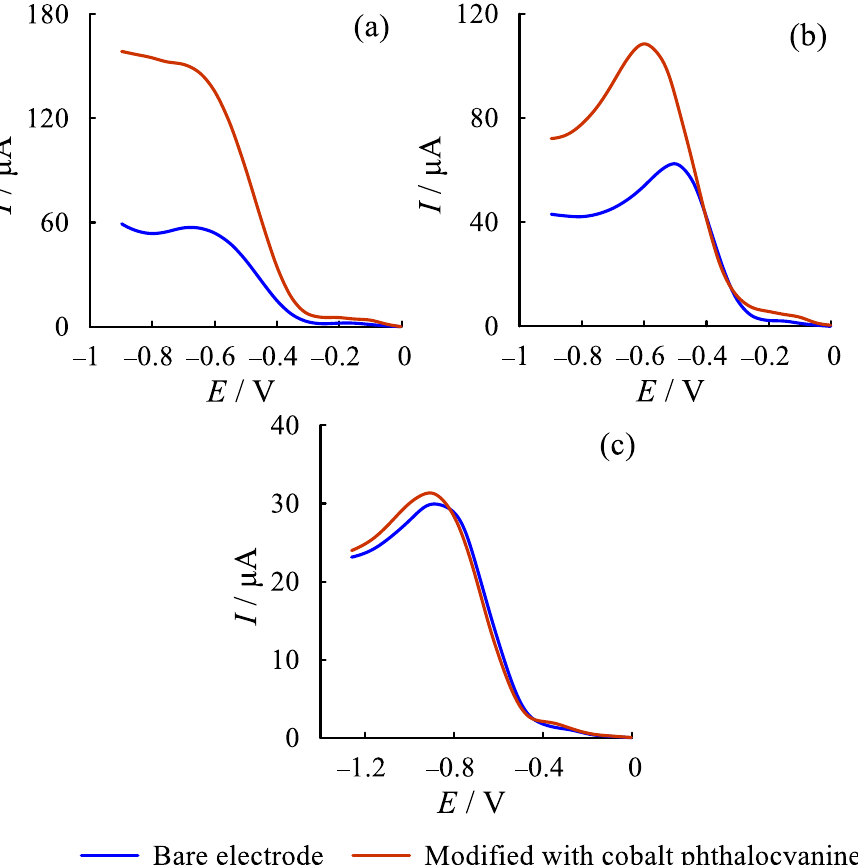
Figure 2. Voltammograms of the electroreduction of oxygen (ER O 2 ) current in phosphate buffer (2.5 × 10 − 2 M, pH 7.3) on the graphite electrode ( a ), glassy carbon electrode ( b ), and platinum electrode ( c ). Scan rate: 50 mV s −1 .